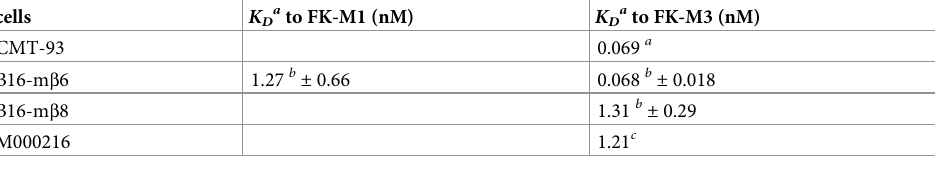
Table 5. Equilibrium data of high-affinity knob interaction measured by binding saturation to cellular integrins.